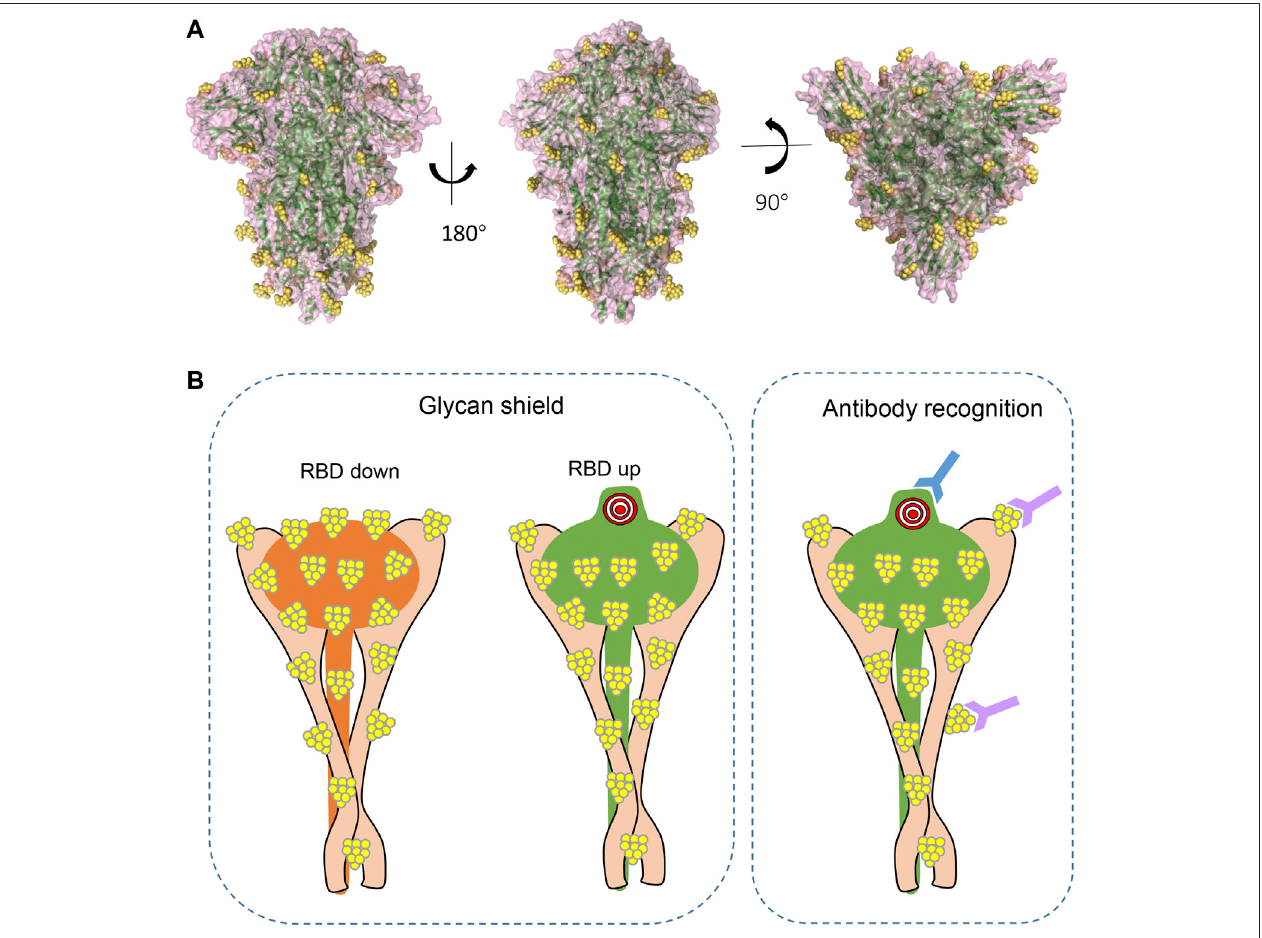
FIGURE 4 | The shielding effect of glycosylation on the S protein trimer (A) . Structural representations from different views demonstrating glycan epitopes. Yellow balls represent glycans, and S backbone was generated based on PDB ID: 6VXX. (B) . Diagram of glycans in molecular recognition shielding and their potential role in antibodyelicitation(leftpanel:comparedtoRBDin “ up ” position,RBDin “ down ” positionhaslargercoverageofglycan;rightpanel:inadditiontopeptideepitopes,some glycans can also be recognized by antibody and are thus important epitopes in antibody